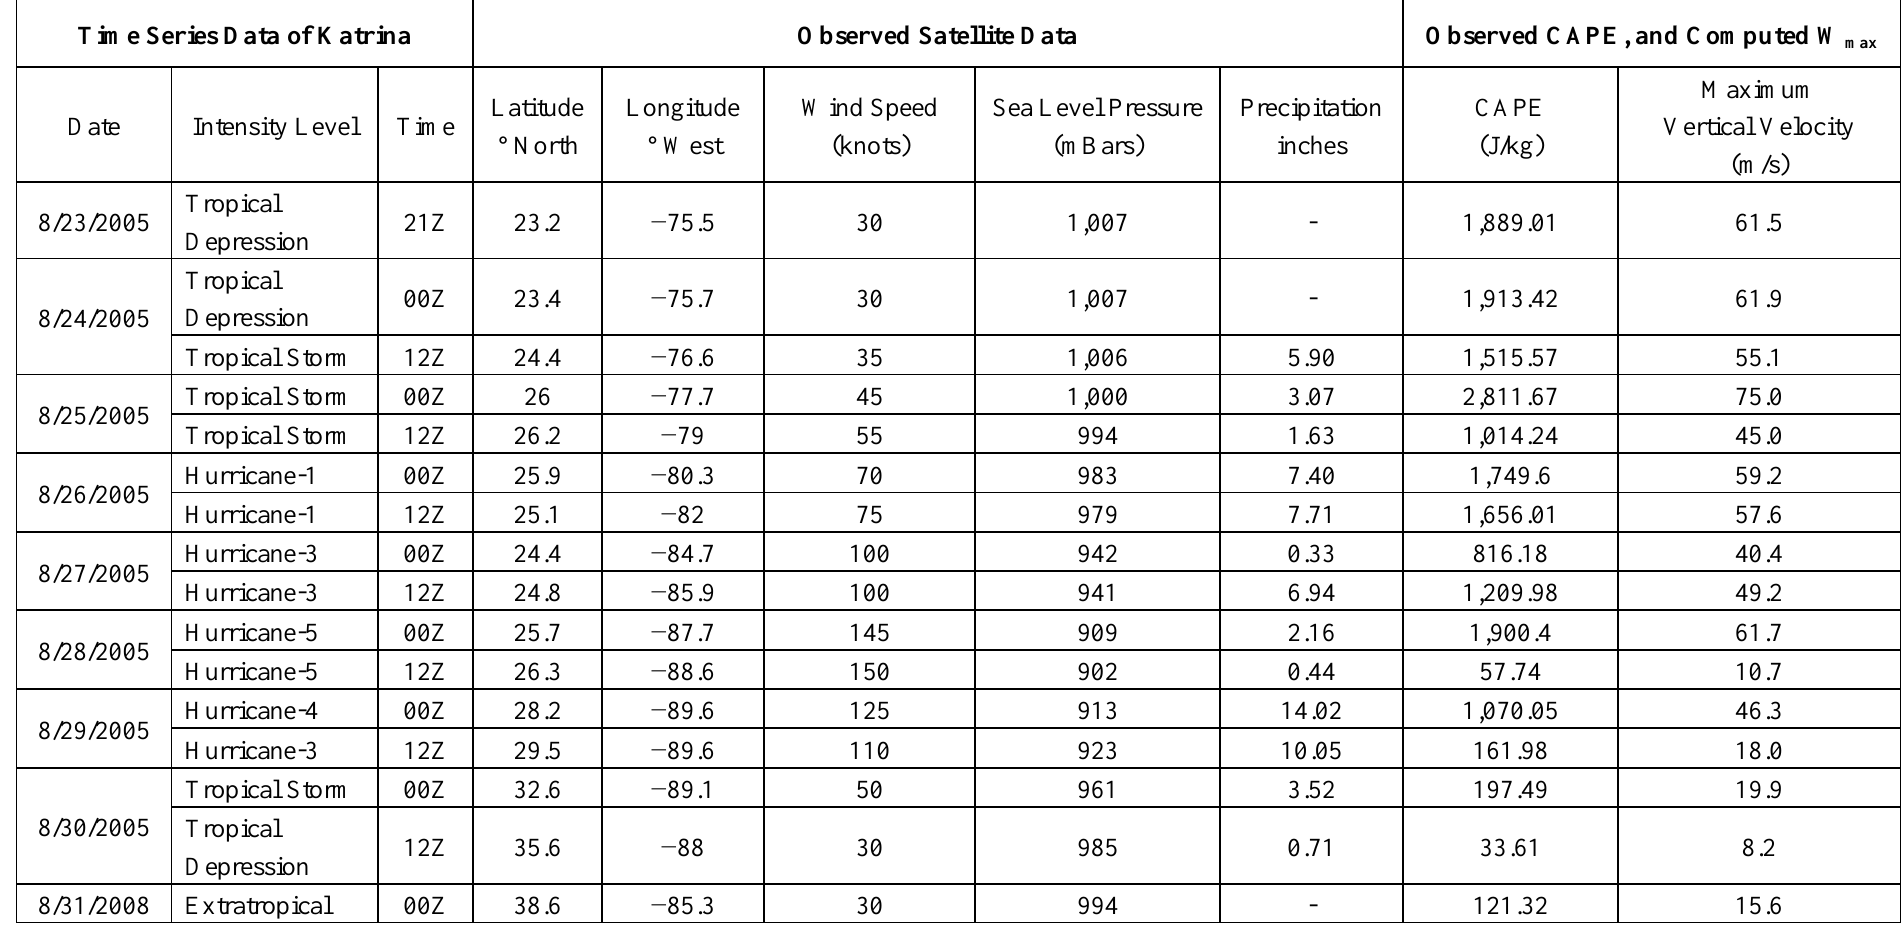
Table 2. The observed time series (8/23/2005 to 8/31/2005) data of hurricane Katrina is taken from NHC [9,10]—Intensity level, location, wind speed, sea level pressure, and precipitation. Observed CAPE values are from the atmospheric sounding indices [23], and the maximum vertical velocity (W ) is computed from the observed max